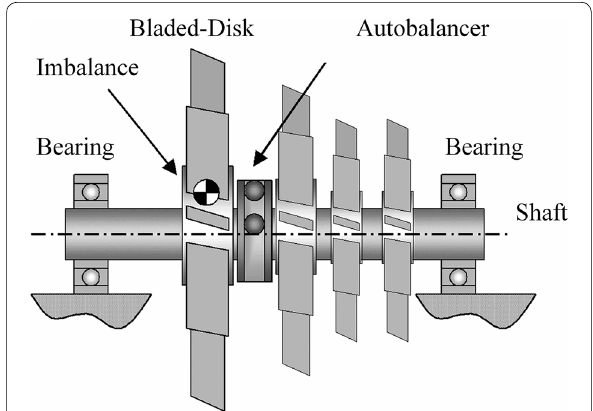
Figure 28 A double-ball automatic balancing actuator